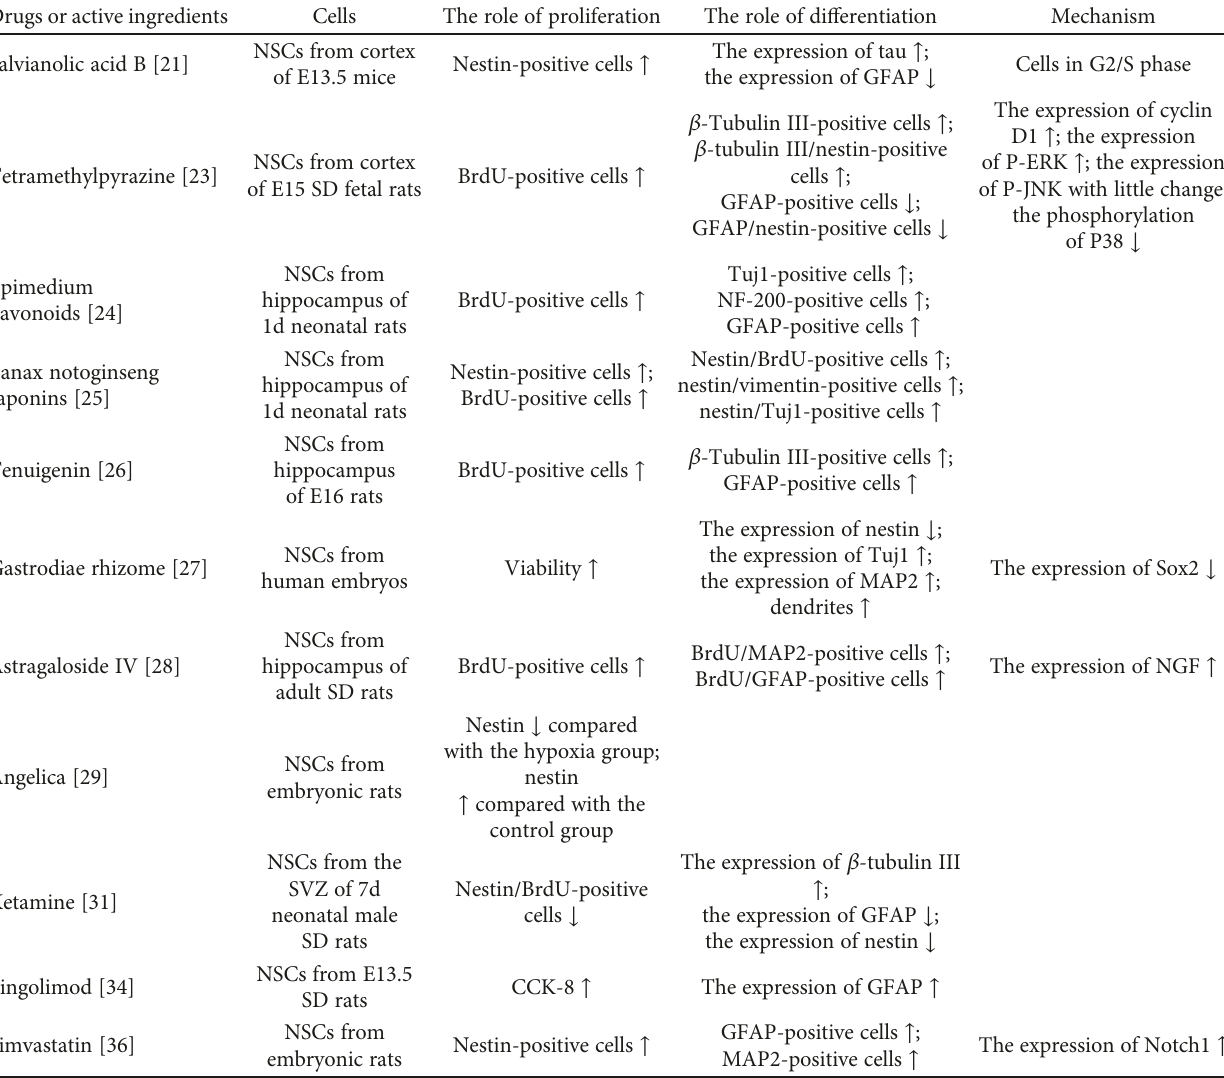
Table 1: E ff ects of drugs or active ingredients on the proliferation and di ff erentiation of